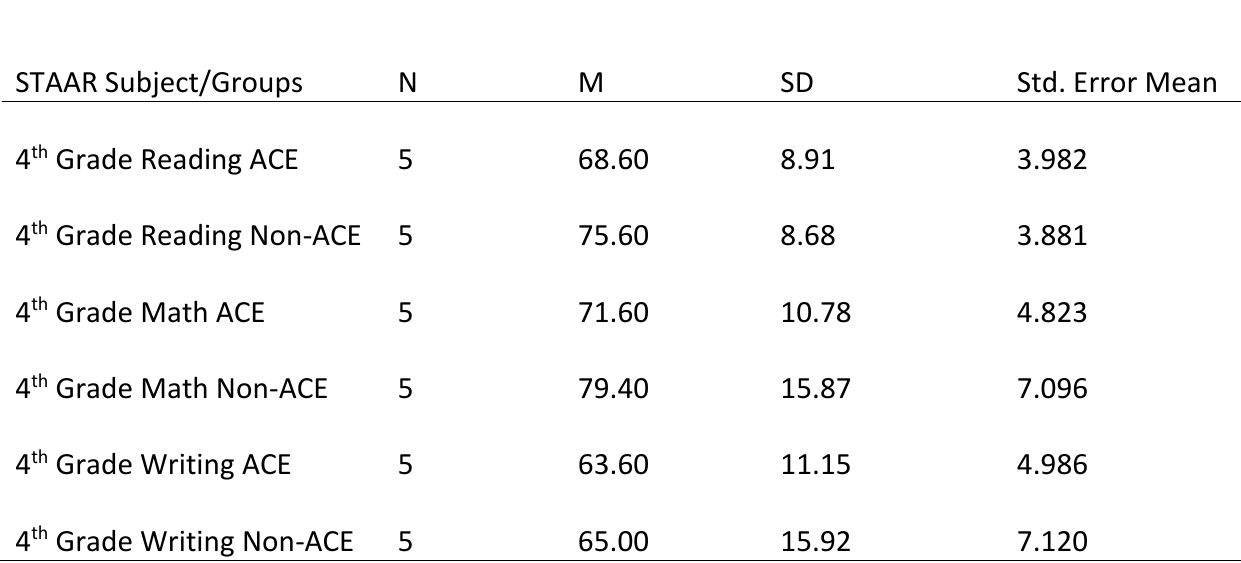
Table 8 : Group Statistics: 4 th Grade Student Performance on STAAR Reading, Math, Writing, in campuses implementing ACE and those campuses which do